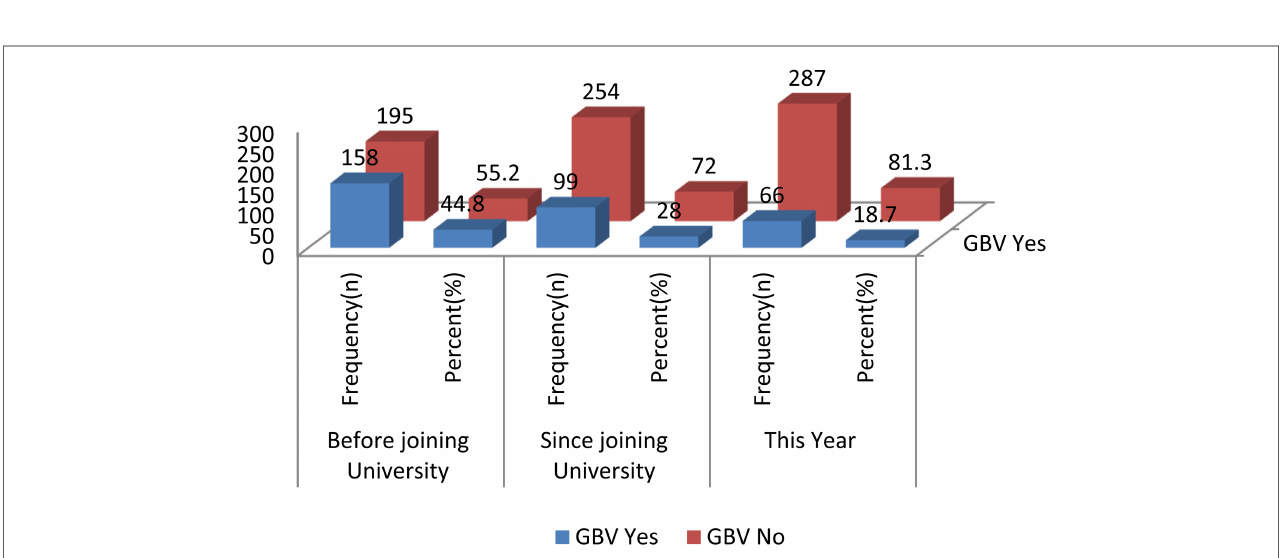
FIGURE 2 Prevalence of GBV before joining University, since joining University and this year among female University students, southwest Ethiopia, 2021.